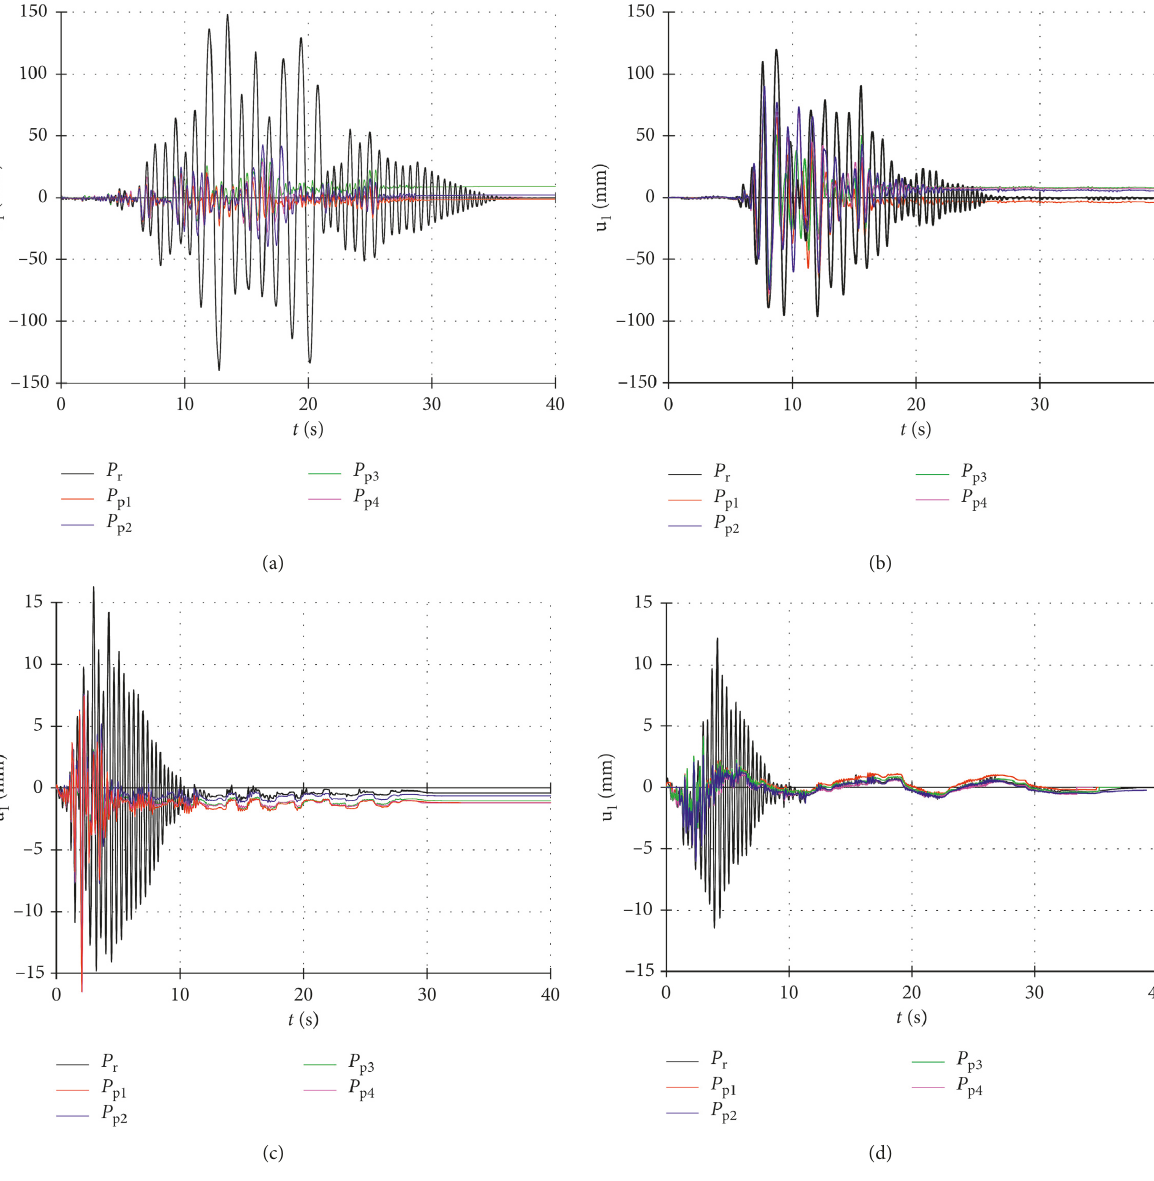
). (a) Artificial accelerogram (AA). (b) Accelerogram Petrovac 1